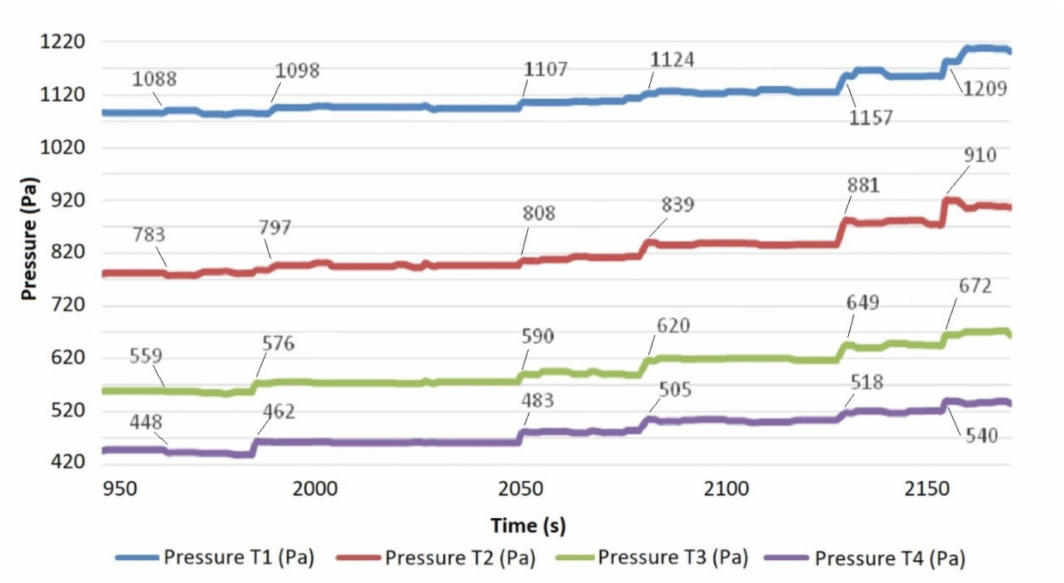
Figure 13. Gradual sealing of the